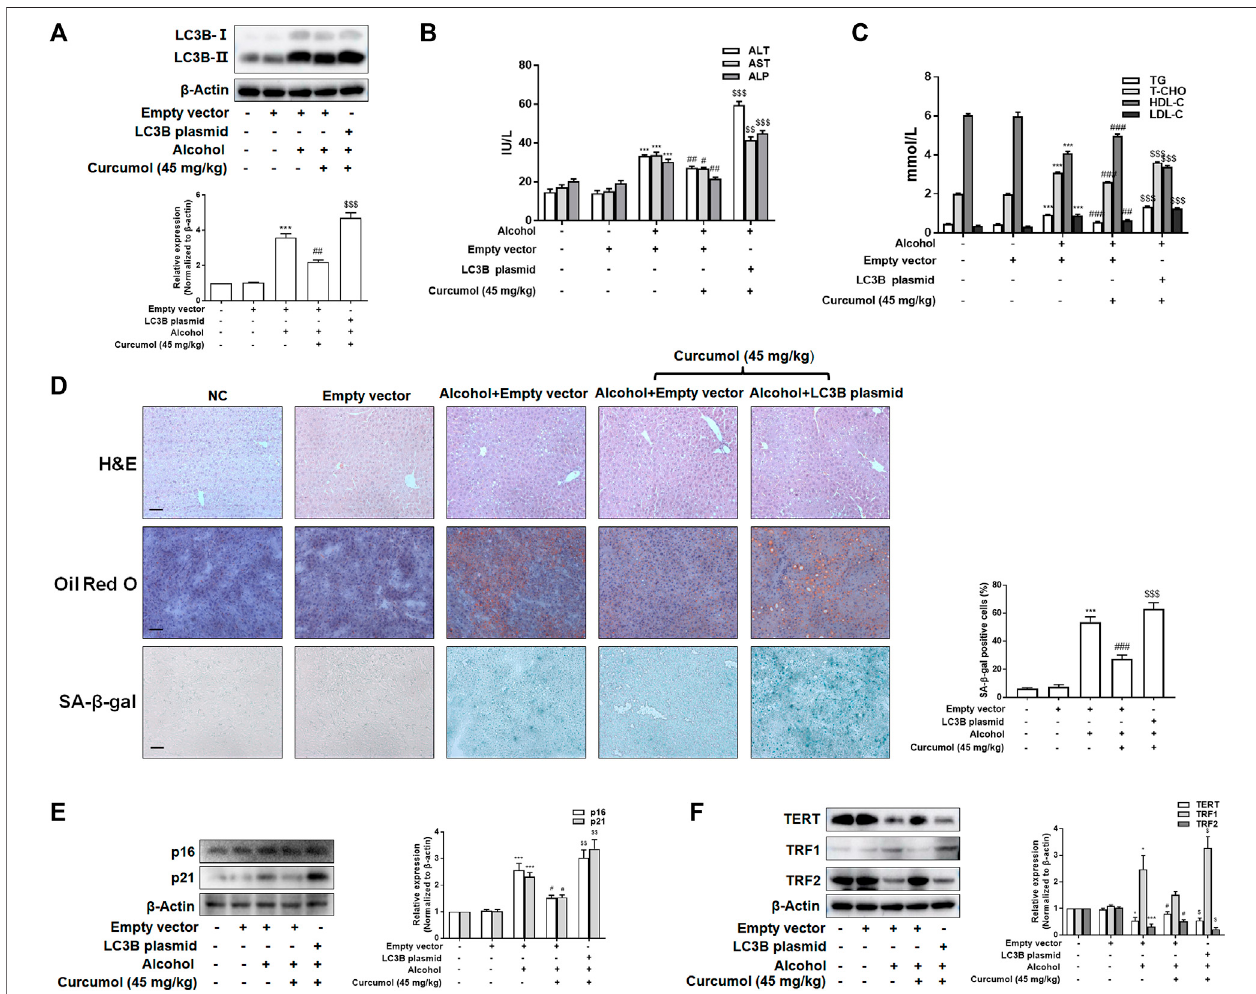
FIGURE 7 | Curcumol ’ s repression of the interaction of LC3B-lamin B1, which ameliorates lipid accumulation and cellular senescence in the liver of AFLD. (A) Westernblotanalysesofthetransfectionef fi ciencyofLC3Boverexpressionplasmid, n =3.Dataarerepresented asmean±SD.Signi fi cance: *** p < 0.001versusempty vector group, ## p < 0.01 versus empty vector + ethanol group, $$$ p < 0.001 versus empty vector + ethanol + curcumol group. (B and C) Determination of serum ALT, AST,ALP,T-CHO,TG,LDL-C,andHDL-Clevels, n =5.Dataarerepresentedasmean±SD.Signi fi cance:*** p < 0.001versusemptyvectorgroup; # p < 0.05, ## p < 0.01, ### p < 0.001 versus alcohol + empty vector group; $$ p < 0.01, $$$ p < 0.001 versus alcohol + empty vector + curcumol (45 mg/kg) group. (D) Liver sections were stained with H&E, oil red O staining, and SA- β -gal staining. Scale bars, 100 μ m. Data are represented as mean ± SD. Signi fi cance: *** p < 0.001 versus empty vector group, ### p < 0.001versusemptyvector+alcoholgroup, $$$ p < 0.001versusemptyvector+alcohol+curcumolgroup. (E and F)